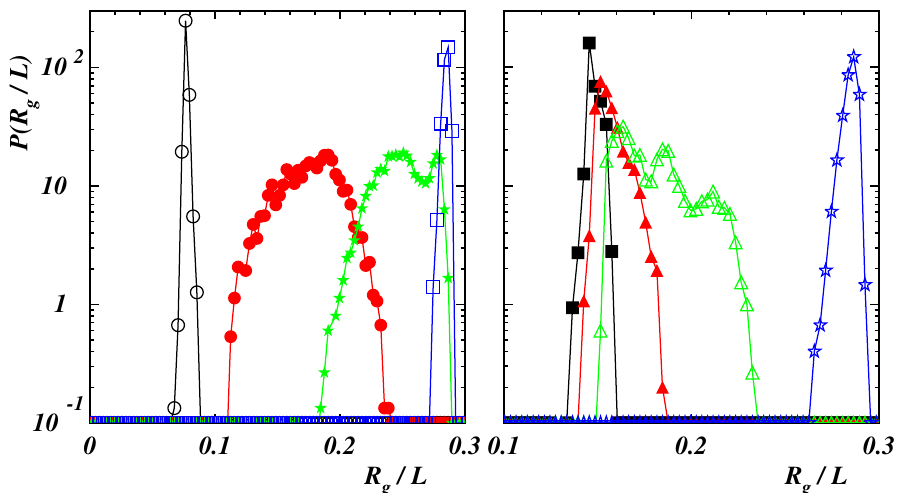
Figure 5. ( Left panel) Normalized probability distribution function of the gyration radius R g for F 1 = NFr 0 / ( k B T ) = 1 (black open circles), 4 (red filled circles), 7 (green filled stars), 20 (blue open squares) with L p / L = 0.2 and (cid:101) / ( k B T ) = 2. ( Right panel) Normalized probability distribution function of the gyration radius R g for F 2 = NFL p / ( k B T ) = 100 (black filled squares), 120 (red filled triangles), 150 (green open triangles), 200 (blue filled stars) with L p / L = 0.8 and (cid:101) / ( k B T ) =